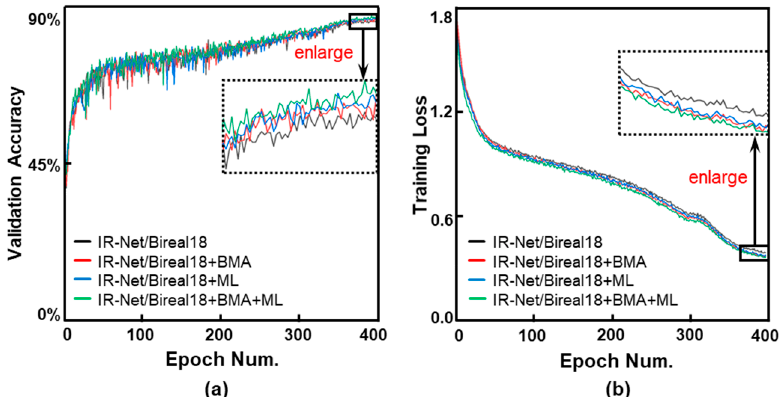
Figure 6. ( a ) Validation accuracy curves and ( b ) Training loss curves during the training process. Baselined IR-Net/Bireal18, improved three schemes with BMA, ML, and both BMA+ML are evaluated and illustrated. All cases are with λ = 10 − 4 . Table 4. Accuracy results of IR-Net/BiReal-18 baseline and improved versions with our proposed ML, BMA, and ML+BMA both (all three cases are with λ = 10 − 4 ). The best results are shown in bold.